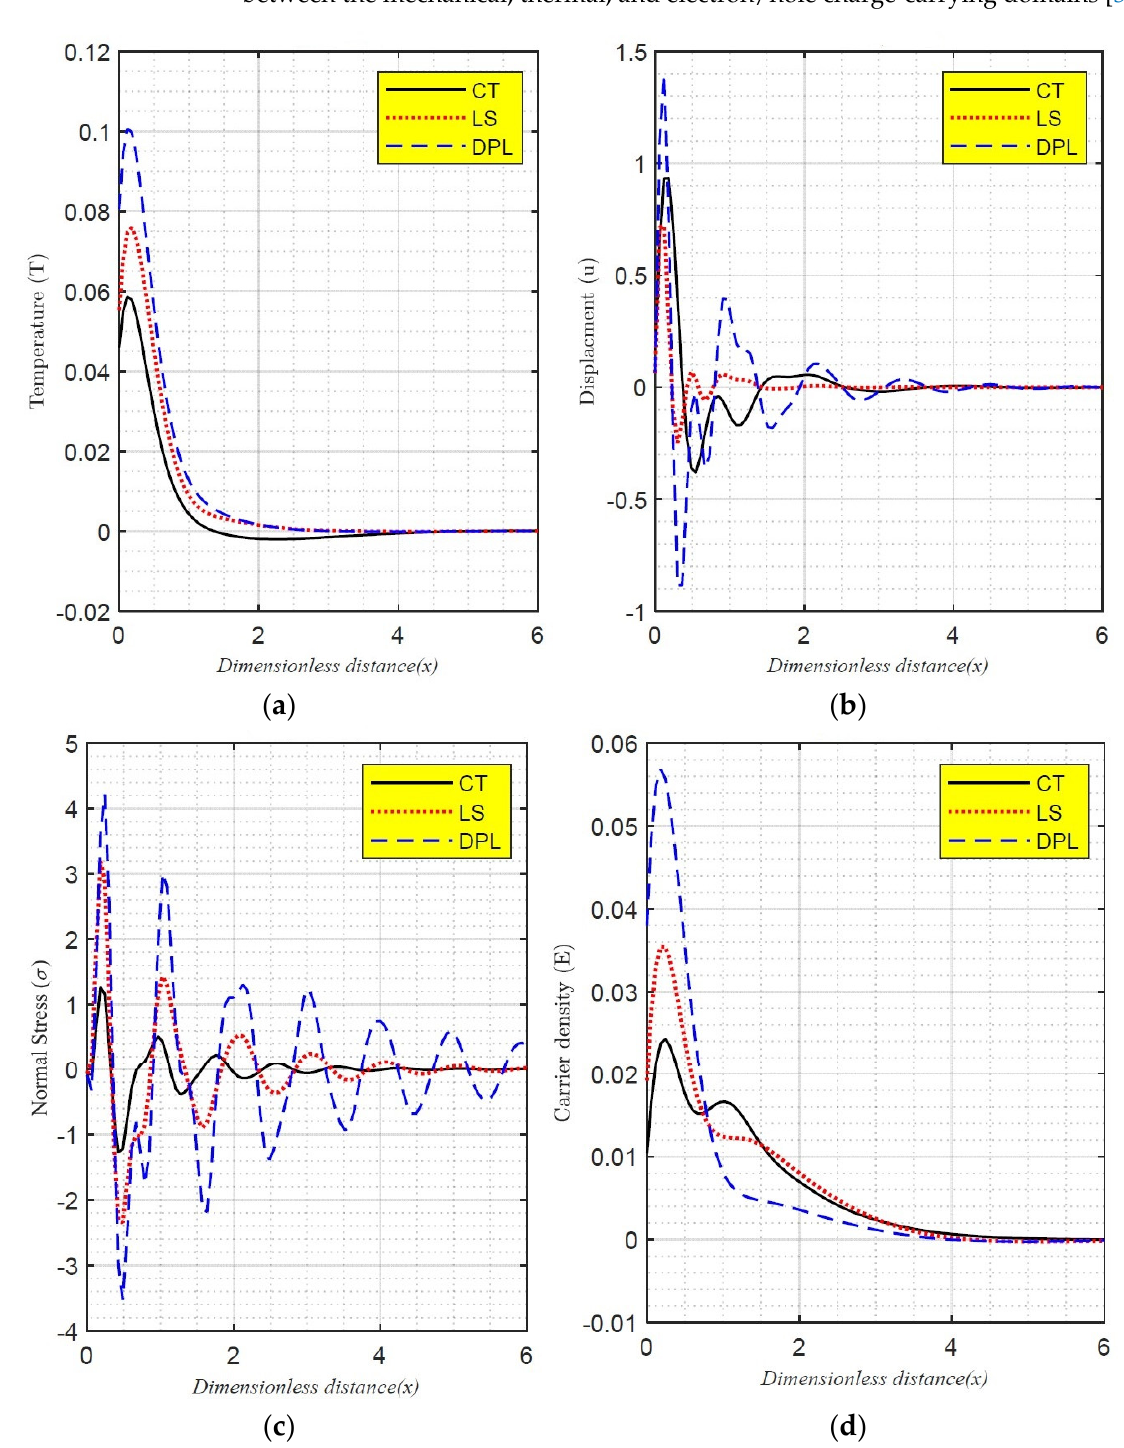
Figure 2. ( a – d ) The comparison between the physical field distributions against the distance according to the different values of thermal memories under the effect of laser pulses for Si material.